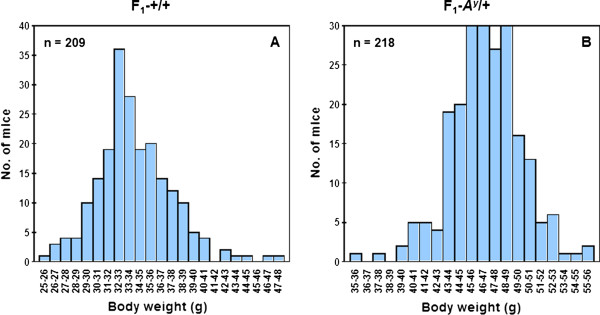
The distribution of body weight in F1-+/+ (A) and F1-Ay/+ (B) hybrids.